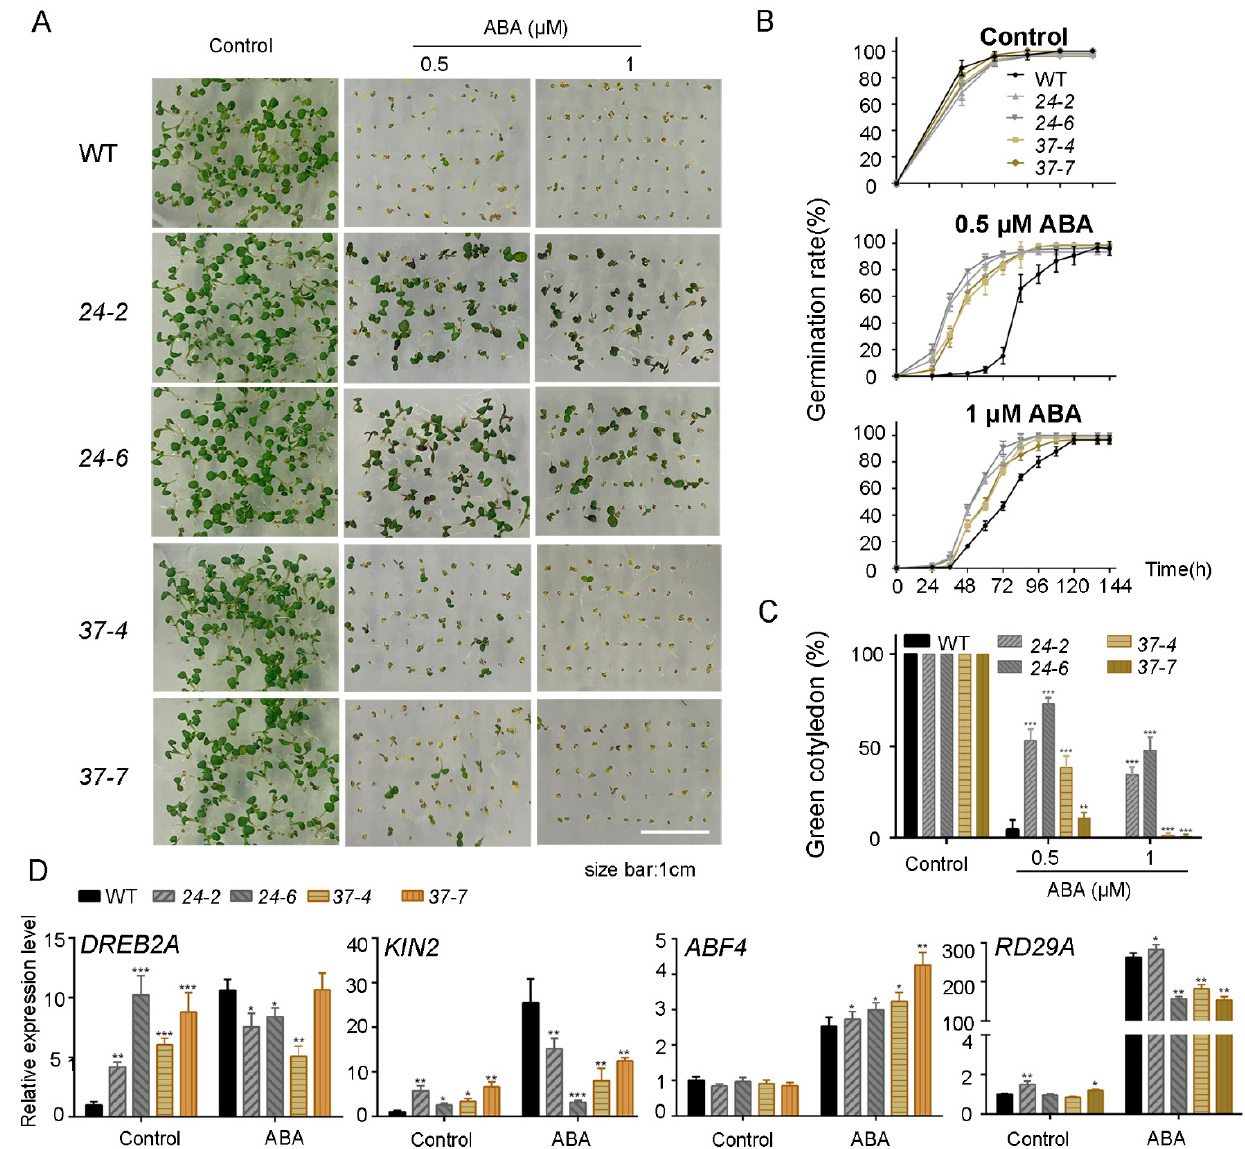
Figure 3. Phenotypic analysis of overexpression of MdPP2C24/37 in Arabidopsis revealed a hyposensi- tive phenotype to ABA at the seed germination stage. ( A ) Representative images of seed germination. ( B ) Statistical analysis of seed germination rate. ( C ) Cotyledon greening rate in WT and transgenic lines 6 days after seeds were sown in MS medium supplemented with 0, 0.5, and 1 µ M ABA. Re- sults represent the mean ± SD from 3 independent experiments. ( D ) Real-time qPCR analysis of stress-responsive gene expression changes in MdPP2C24/37 overexpression lines in Arabidopsis. The expression levels were based on total RNA extracted from WT and MdPP2C24/37 overexpression lines in liquid MS medium, or liquid MS medium supplemented with 50 µ M ABA for 3 h. Results represent the mean ± SE from 3 independent experiments. The expression levels are presented as relative units, with levels under control conditions taken as 1. All experiments were replicated three times with similar results. Values were significantly different from WT at * p < 0.05, ** p < 0.01 or *** p < 0.001.